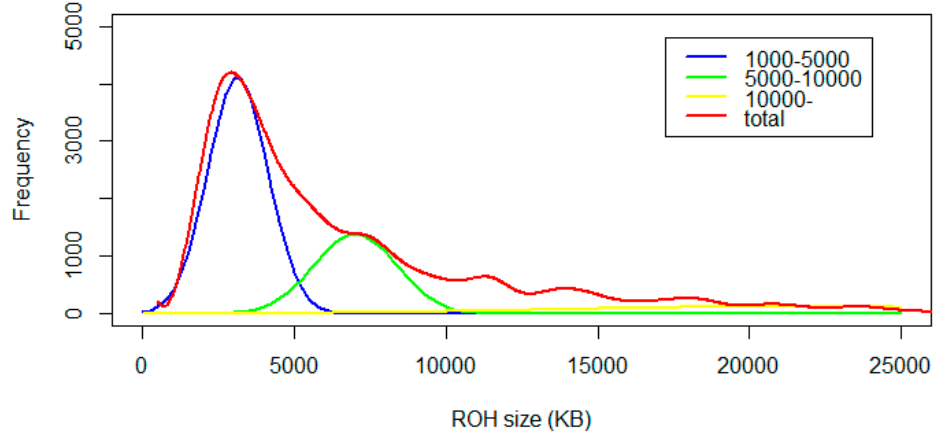
Figure 2. Density estimates of runs of homozygosity (ROH) in three size categories. The x ‐ axis indicates the size of ROH (Kb), the y ‐ axis indicates the value of density.